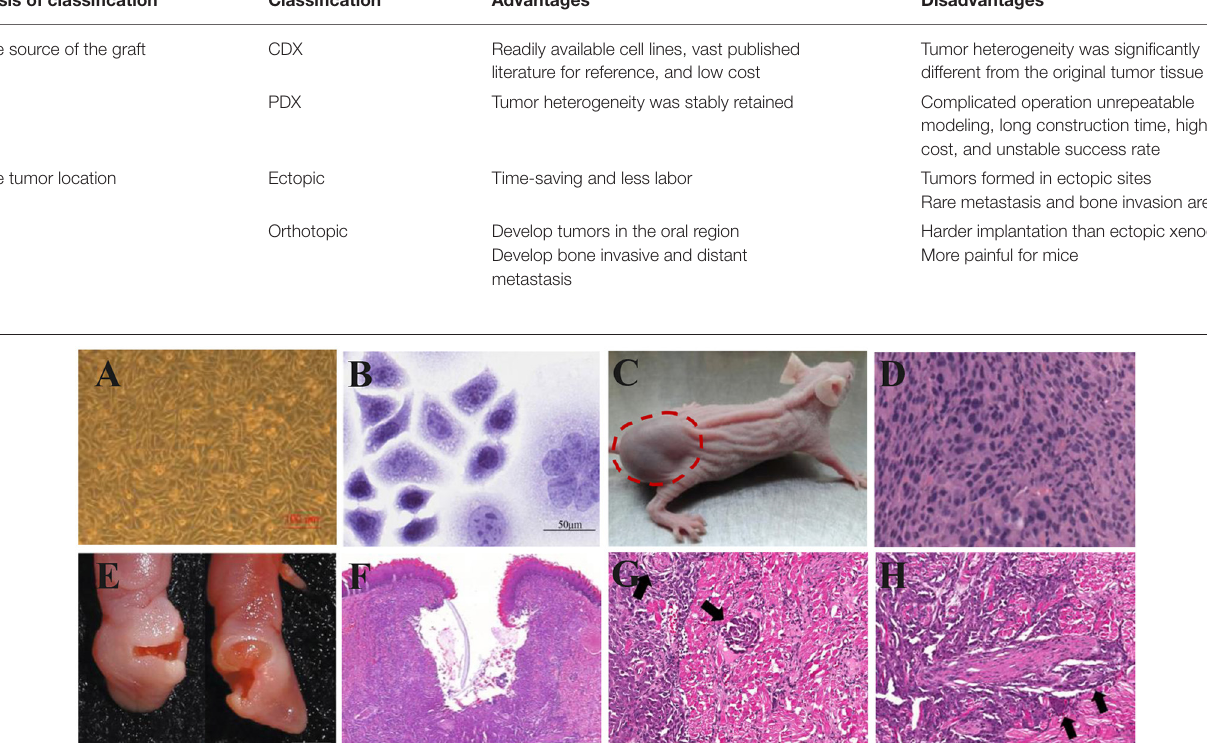
TABLE 2 | Classifications of Xenograft mouse models. Basis of classification